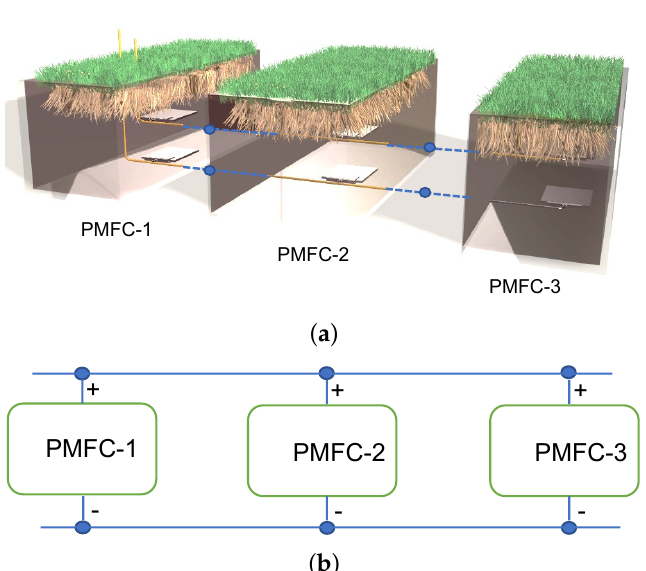
Figure 3. PMFC-based grass forage-power cell: ( a ) PMFC power array, and ( b ) equivalent PMFC schematic